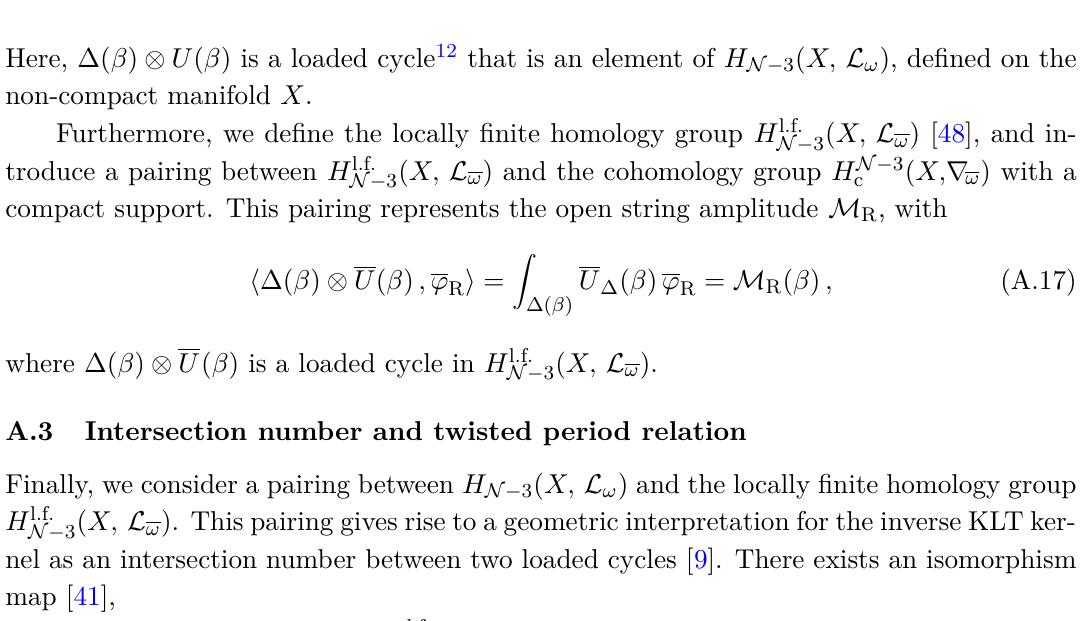
( z ) is a circle centered at z with radius (cid:15) (cid:15)